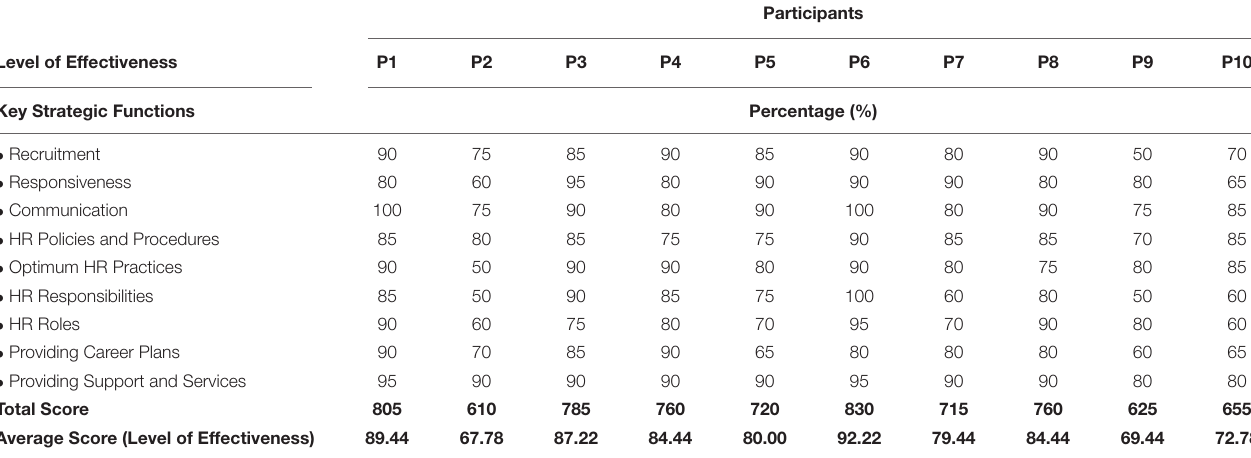
TABLE 2 | The level of human resources professionals’ effectiveness.